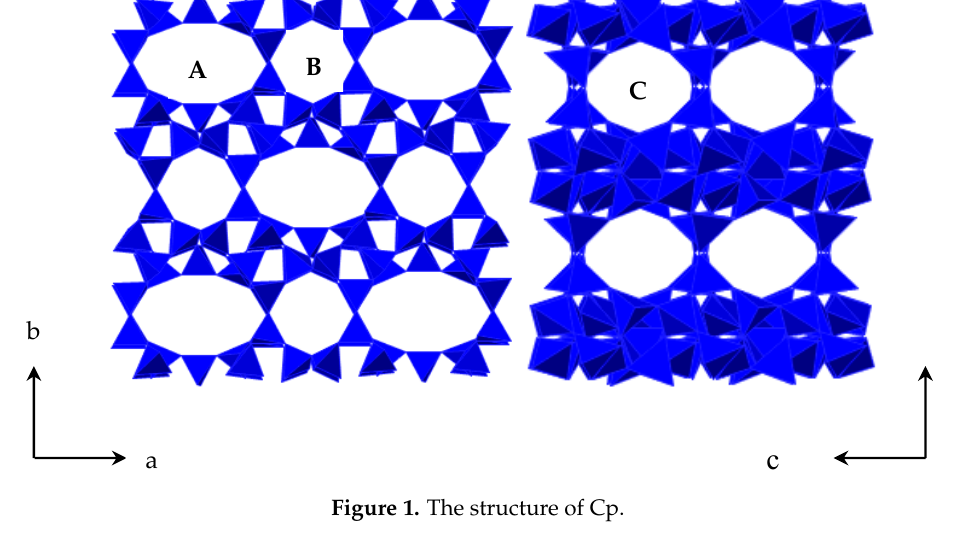
Figure 1. The structure of Cp.